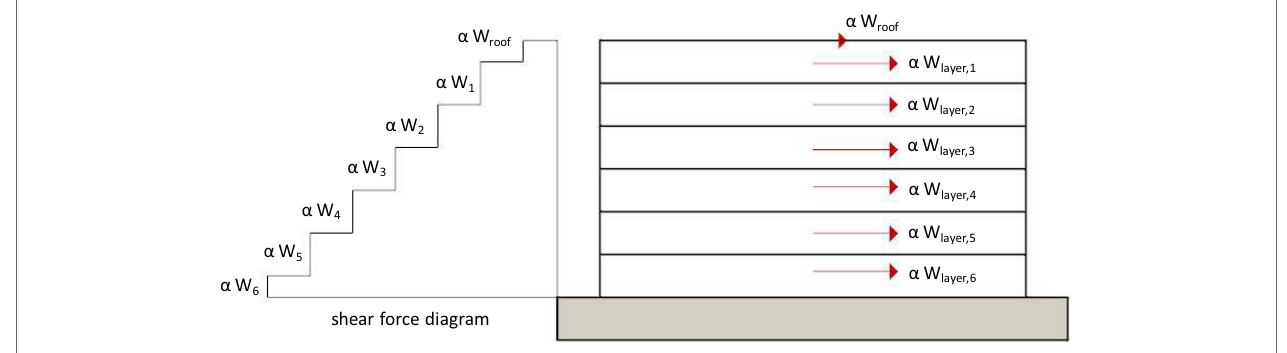
FIGURE 6 | Uniform distribution of lateral seismic